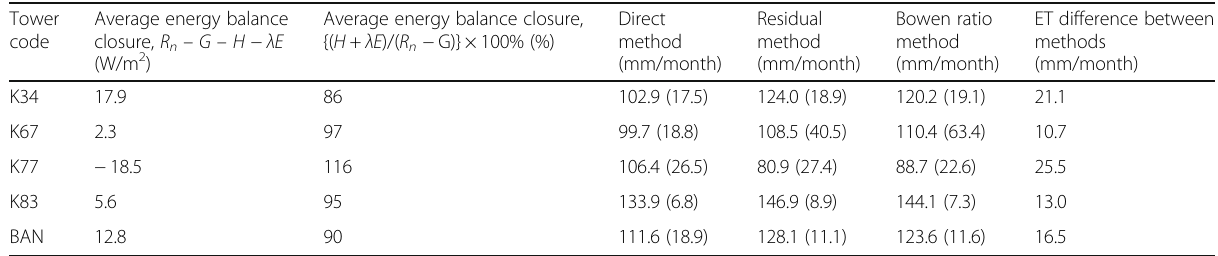
Table 2 Energy balance closure statistics at the LBA flux sites and ET measurement results showing uncertainty compared to ground truth data. The standard deviation is indicated between brackets Tower